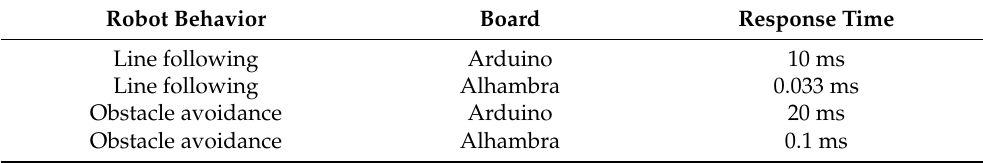
Table 4. Time response for reconfigurable computing and software approaches.